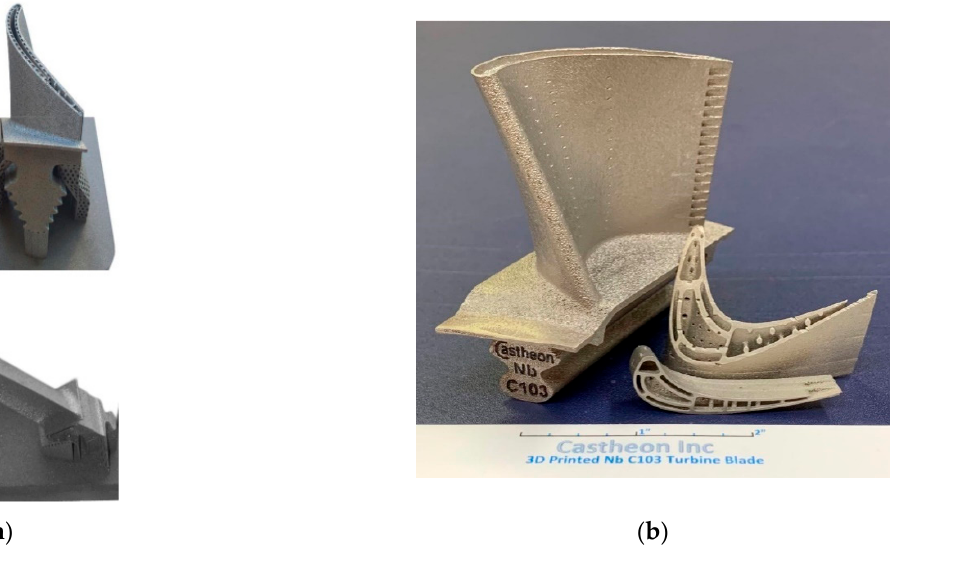
Figure 3. ( a ) Build orientations for coupons, and ( b ) cut-section view of the test rig and the additively manufactured coupons showing the internal channel (which can have either coflow or counterflow direction with respect to mainstream flow) to feed the film cooling holes (Stimpson et al. [16]).